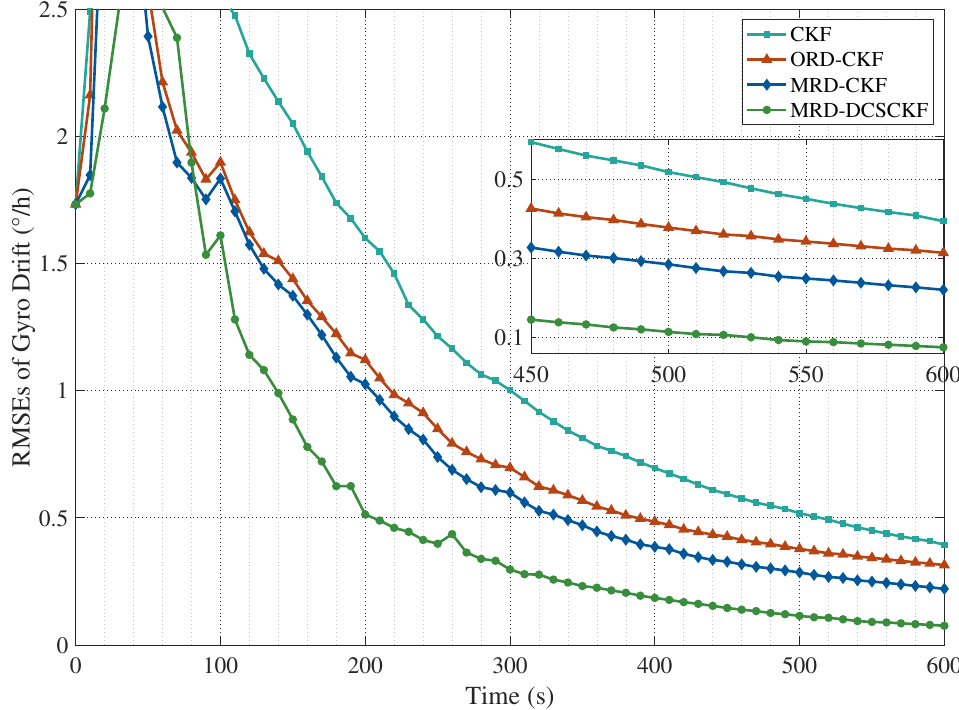
Figure 11. RMSEs of the gyro drift with CKF, ORD-CKF, MRD-CKF, and MRD-DCSCKF. Figures 12–15 present the tracking errors of MRD-DCSCKF. As can be seen, the error curves converge quickly to the 3 σ bounds, which are indicated by the dashed line. This demonstrates that the convergence property of MRD-DCSCKF is